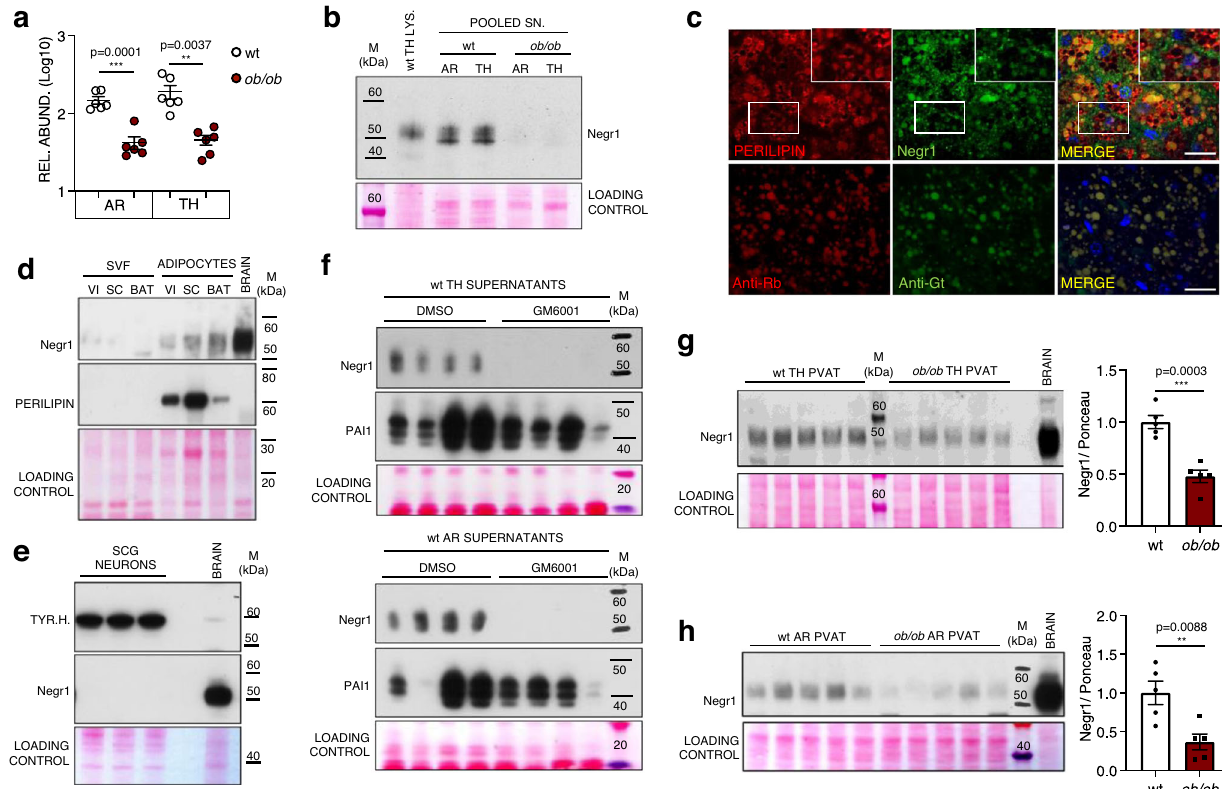
Fig. 6 | Negr1 levels and secretion are reduced in the PVAT of ob/ob mice. a MS-determined relative abundances of Negr1 in the secretomes of wt and ob/ob AR and TH PVAT. N =6 biological replicates per group, unpaired, two-tailed t -test, mean±SEMisshown. b WesternblotonwtTHPVATlysate(LYS.)andsupernatants (SN.)pools( N =6biologicalreplicatesperpool)stainedforNegr1. c Representative immuno fl uorescenceimages(1outof2replicates)showingNegr1localisationinwt THPVAT.Adipocytesarelabelledbyperilipin.NucleiarecounterstainedwithDAPI. Insetsshowhighermagni fi cationofwhiteframedareas.Scalebar:50 µ m. d Western blot showing Negr1 and perilipin levels in stromal vascular fraction (SVF) and adi- pocytes obtained after digestion and fractionation of VI and SC WAT and BAT explants from wt mice (1 out of 2 replicates). e Western blot on primary murine sympathetic neurons lysates from 3 biological replicates stained for TYR.H. and